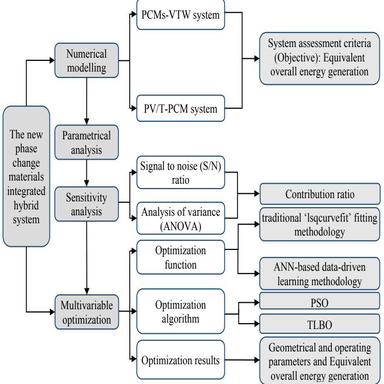
Outline of research methods in this study.